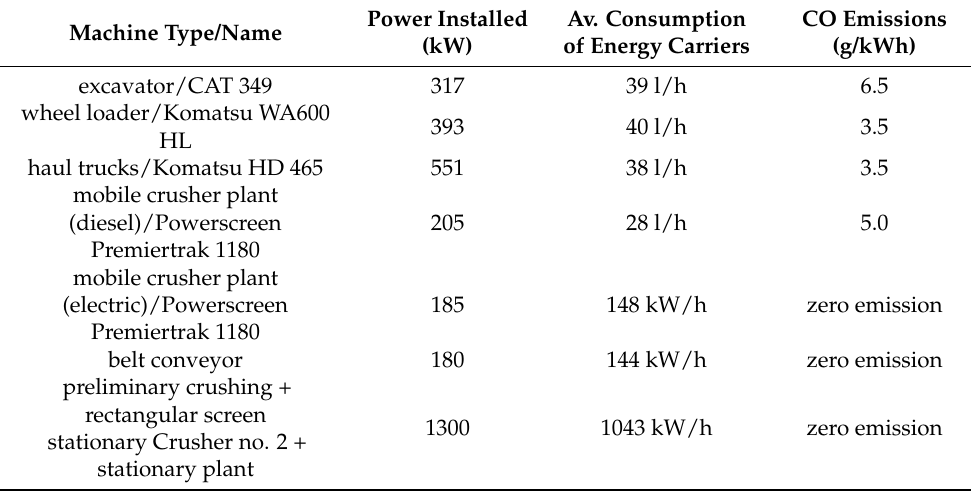
Table 2. Fuel and energy consumption and CO emissions by mining equipment